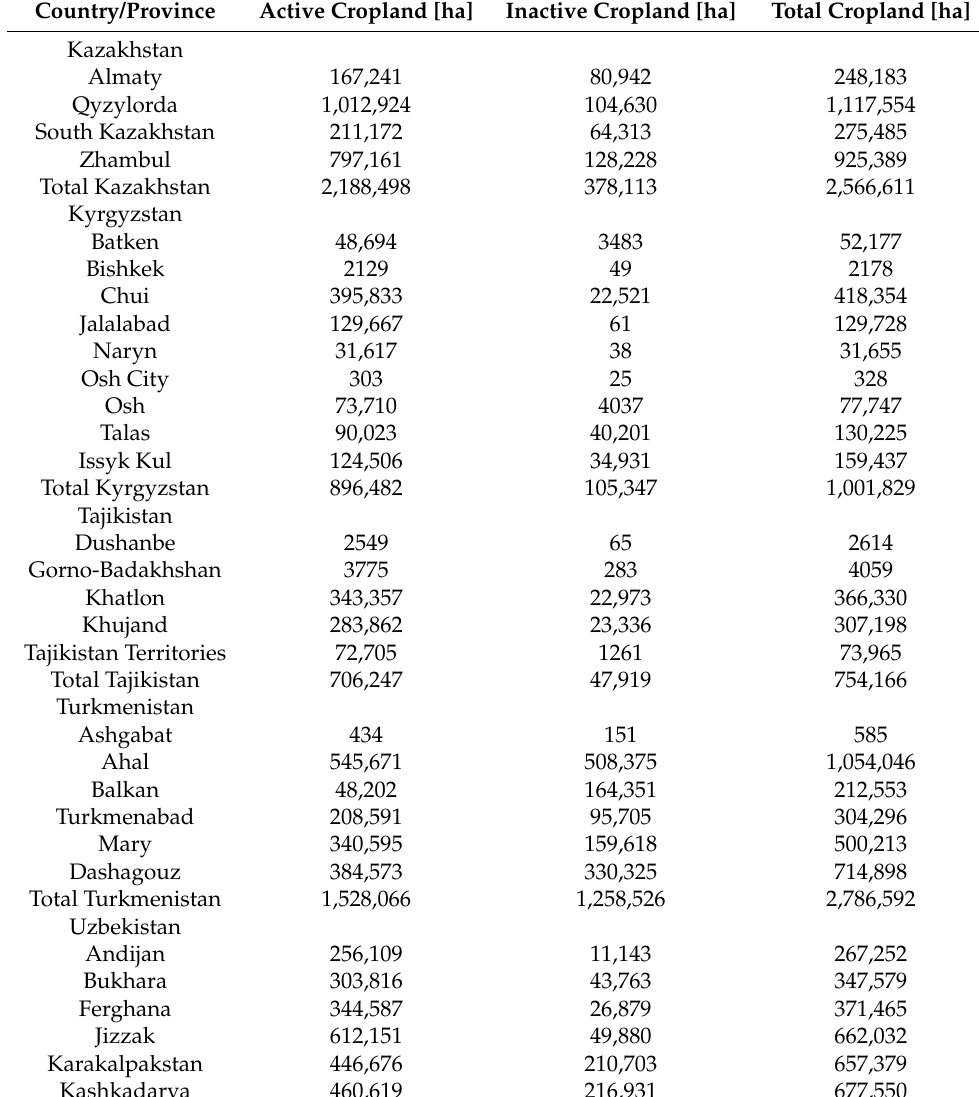
Table 3. Cropland area under irrigated agriculture by country and